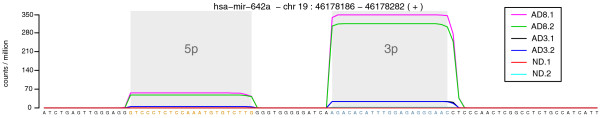
Abundance of each base along the miR-642a pre-miR. Each experimental condition is pictured using the color code in the insert. Light grey shading highlights miR-642-5p (bases in orange) and miR-642-3p (bases in blue). Represented samples were sequenced in the 3' to 5' direction.